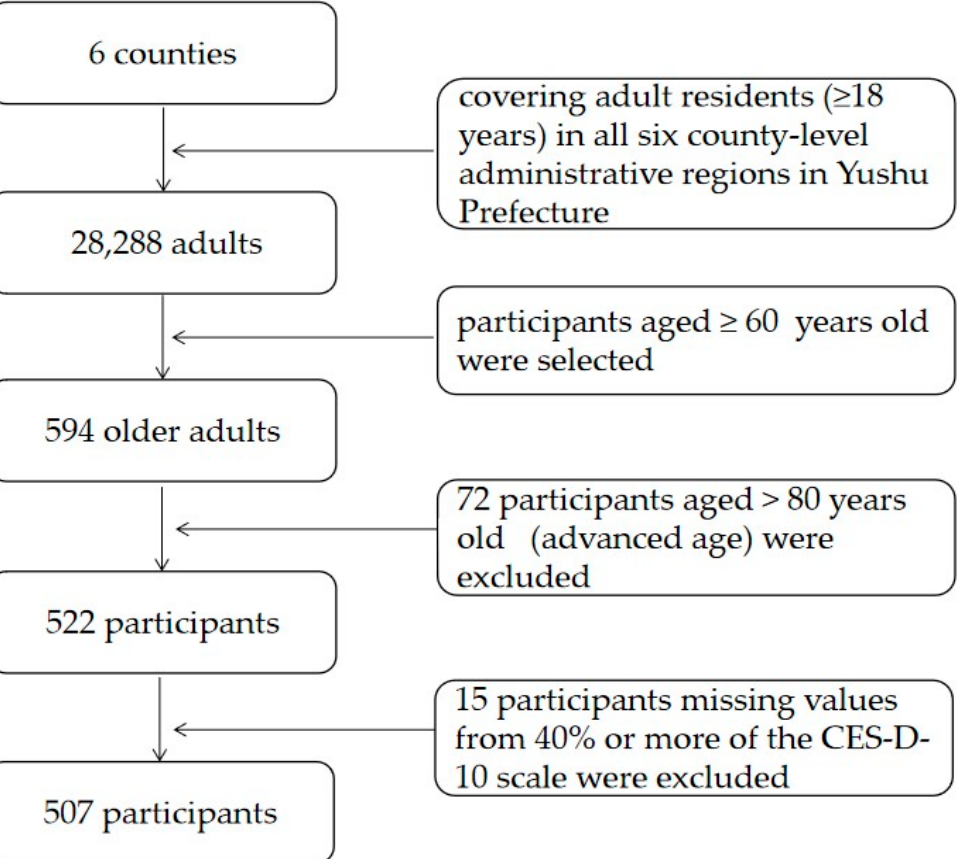
Figure 1. Flow chart of sampling.